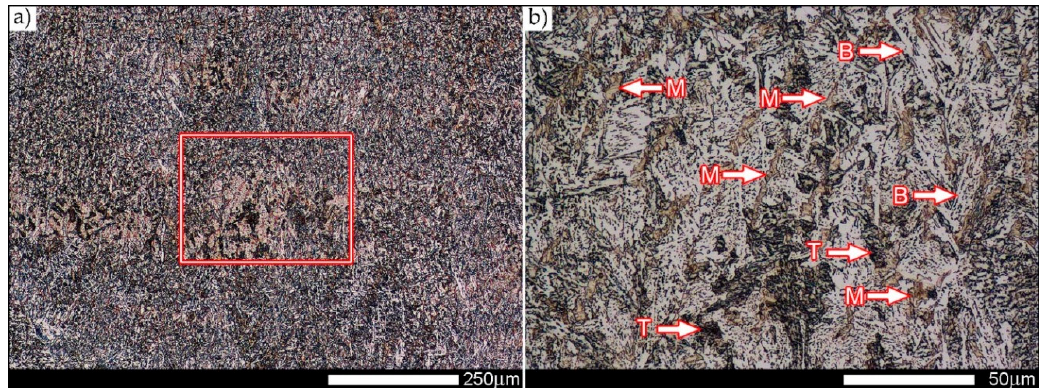
Figure 12. Microstructure of Hardox Extreme welded joint after welding: ( a ) in the area marked WM3 in Figure 5; ( b ) an enlarged image marked with frame in Figure 12a. Clearly visible, morphologically diversified fusion lines 1 and 2 composed of bands of martensite (M) and bainite (B) and colonies of troostite (T) on the background of hardening sorbite. Light microscopy, etched with 2% HNO 3 .